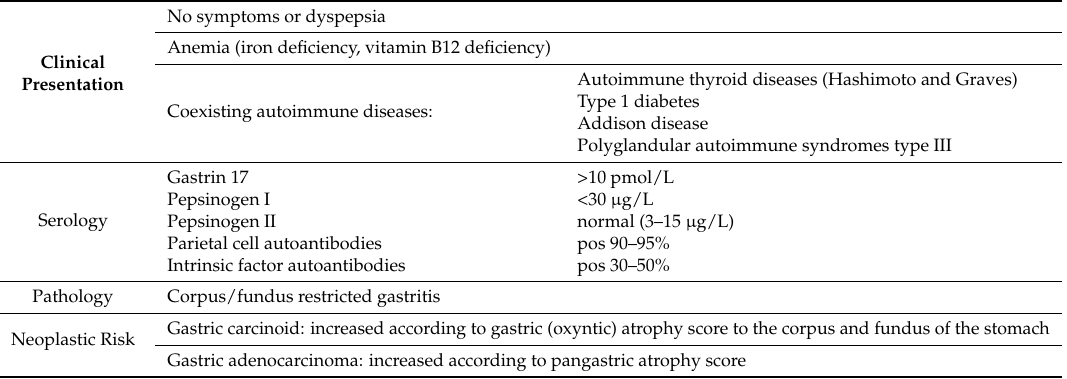
Table 1. Clinical presentation, serology, pathology and neoplastic risk of autoimmune gastritis.